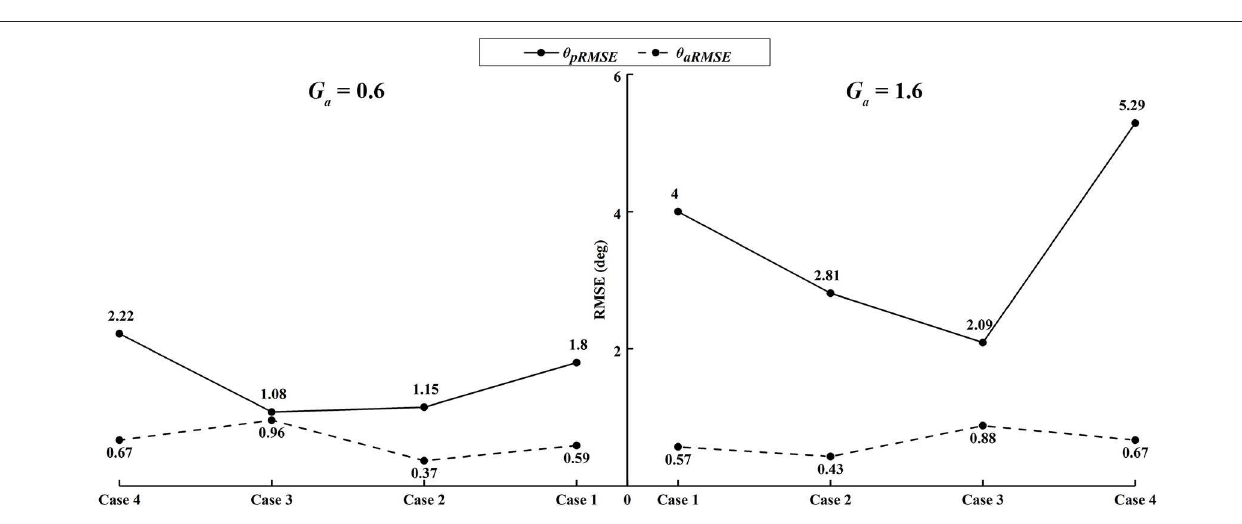
of the ankle mechanism in the ROWAS II system. The discussed